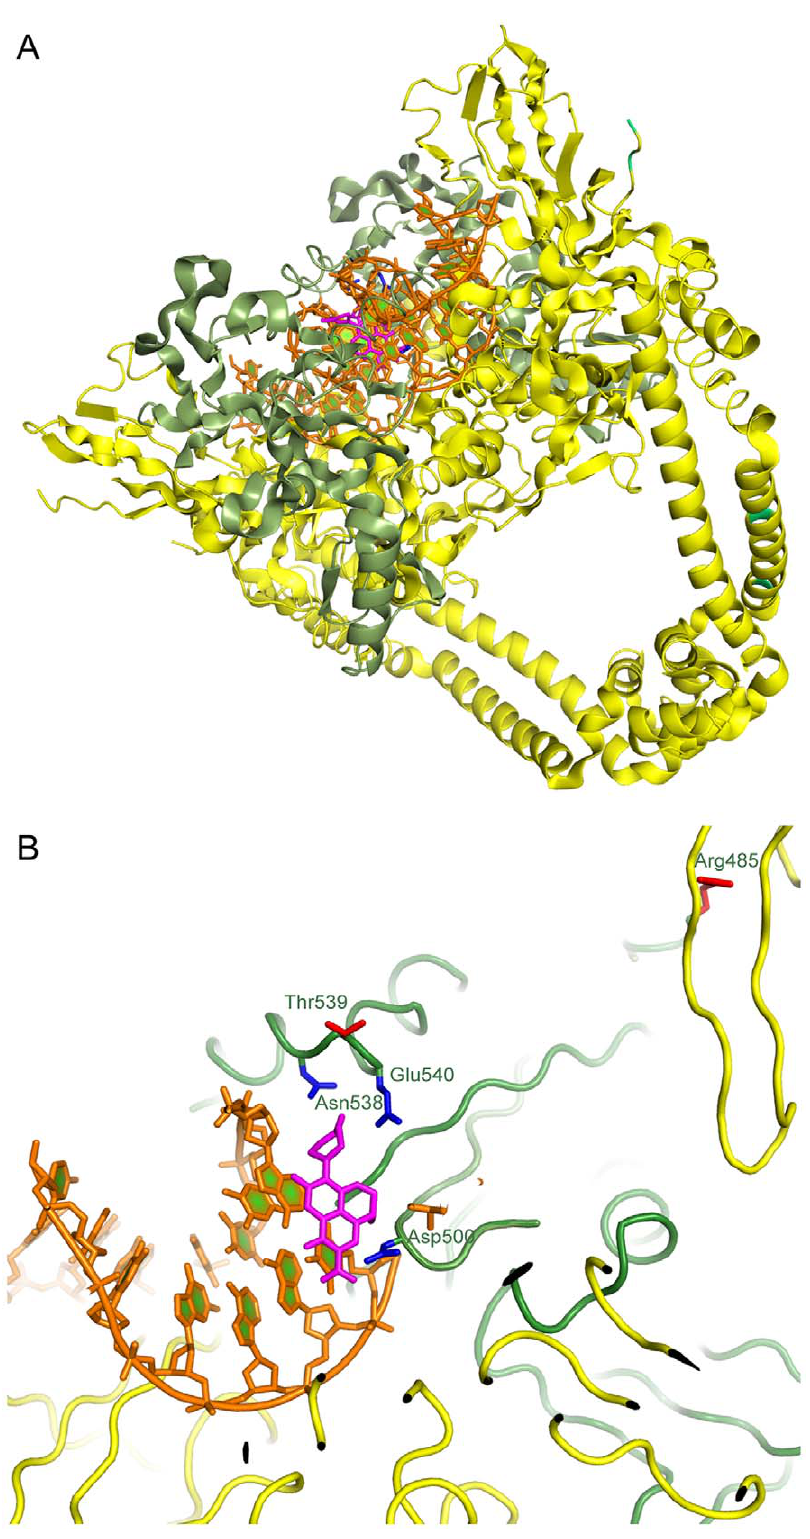
Figure 2. A structural model of M.tuberculosis gyrase inhibition. A. A model of M. tuberculosis gyrase in complex with DNA and levofloxacin. The model was built based on the crystal structure of the complex of Streptococcus pneumoniae (PDB ID: 3K9F) as described in Materials and Methods. The GyrA subunit is shown in yellow, GyrB is in green, DNA is in orange, the levofloxacin molecule is shown as pink sticks. B. A zoomed-in view of the quinolone binding site. Residues that directly interact with the quinolone and whose mutations cause resistance are shown by blue sticks. The two residues whose double, but not single, mutations cause fluoroquinolone resistance are shown by red sticks.